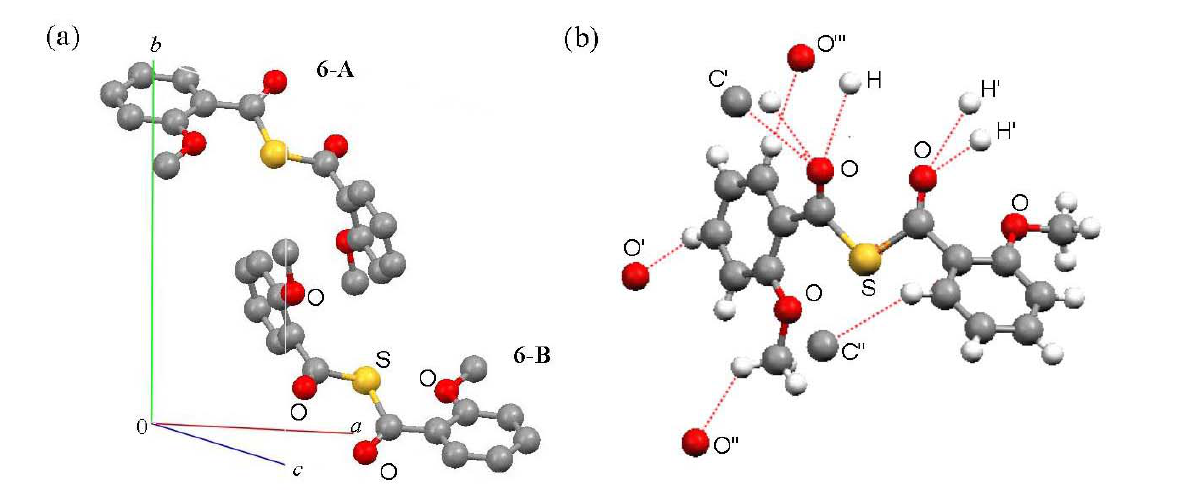
Figure 5. (a) Packings and (b) intermolecular short contacts of (2-MeOC view down to a -axis. Yellow, red, gray and white balls are sulfur, oxygen, carbon and hydrogen atoms, respectively. For (a), hydrogen atoms are omitted for clarity and molecules 6-A and 6-B are enantiomorphic with each other. For (b), red dotted lines show intermolecular short